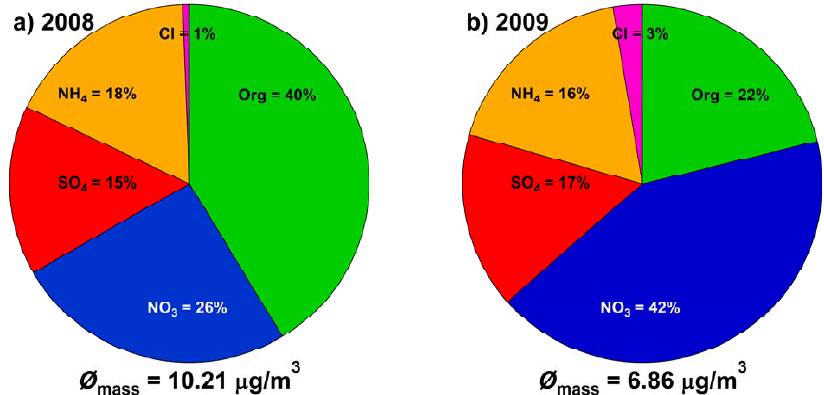
Fig. 2. Mean aerosol composition in May 2008 (left) and March 2009 (right). While the aerosol chemical composition is dominated by organics (40%) in May 2008, the main fraction is composed of nitrate (42%) in March 2009. The average mass loading was 10.21µgm − 3 Figure 2: Mean aerosol composition in May 2008 (left) and March 2009 (right). While the 3 in May 2008 and 6.86µgm − 3 in March aerosol chemical composition is dominated by organics (41%) in May 2008, the main fraction 4 is composed of nitrate (42%) in March 2009. The average mass loading was 10.21 μ g/m 3 in 5 May 2008 and 6.86 μ g/m 3 in March 2009. 6 7